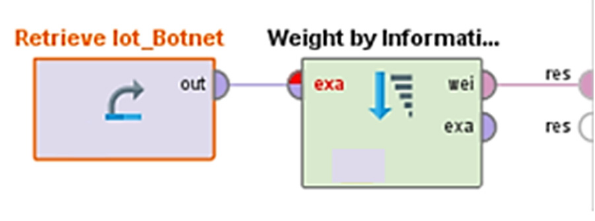
Table 3. Reduced features by Information Gain. Original Number of